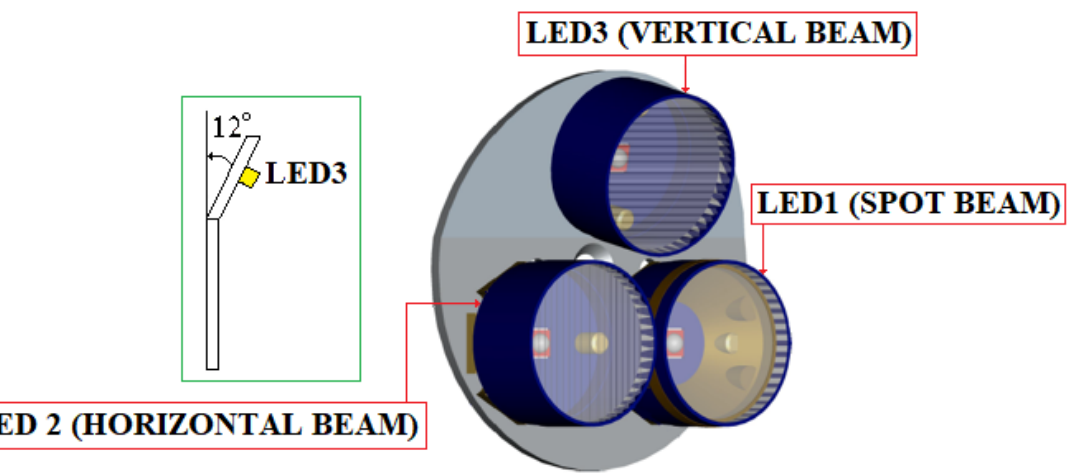
Figure 9. The arrangement of the 3 LEDs within the GEN4-NIOSH lamp headlight [68].